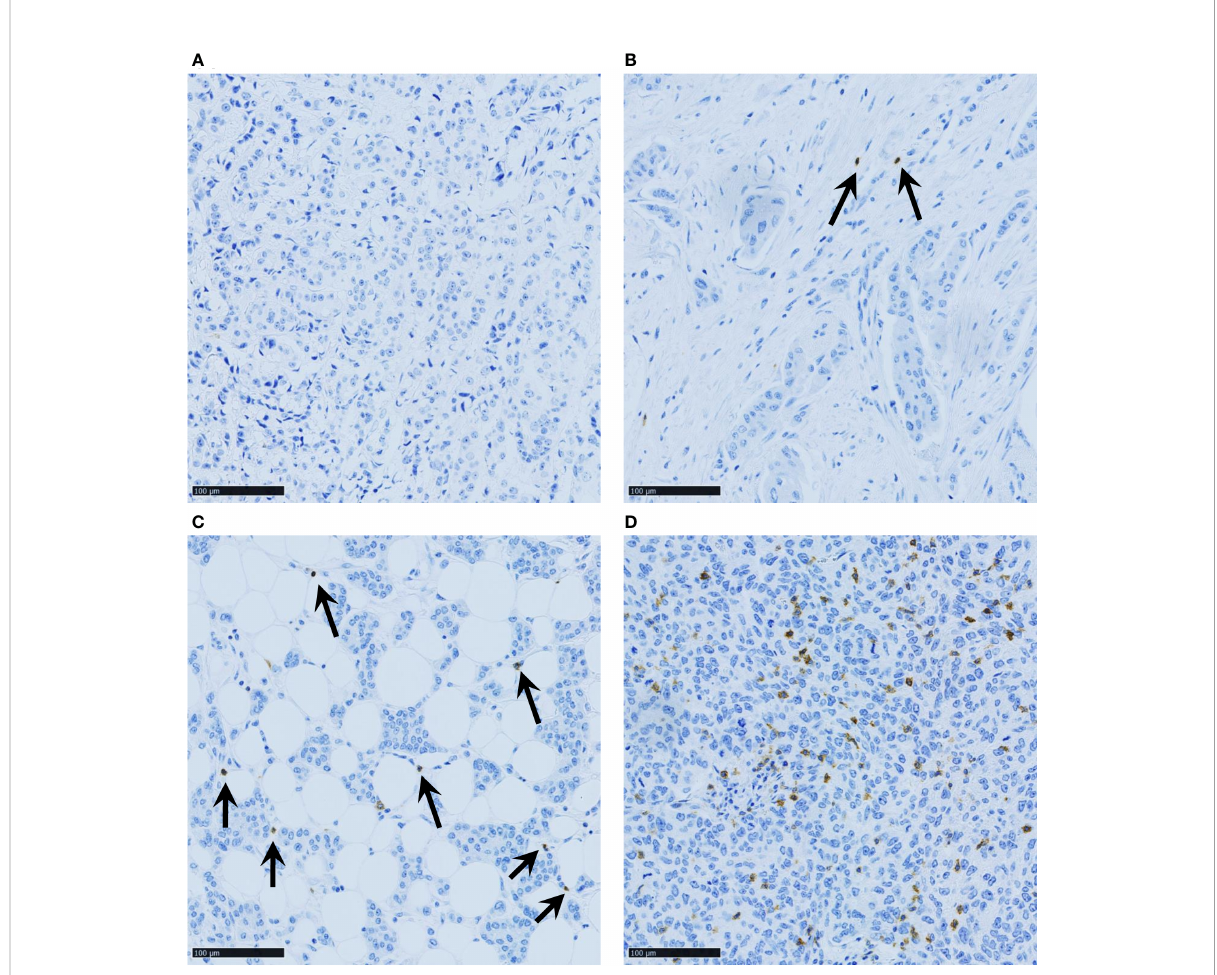
FIGURE 1 Representative images of TNBC samples with various TIGIT + cell densities: (A) score 0 (no TIGIT + cells in the whole core); (B) score 1 (few scattered TIGIT + cells); (C) score 2 (core with some TIGIT + cells, i.e. <20 TIGIT + cells in a x40 fi eld that represents 0.103 mm²); and (D) score 3 (at least one x40 fi eld with ≥ 20 TIGIT + cells). Scale bar